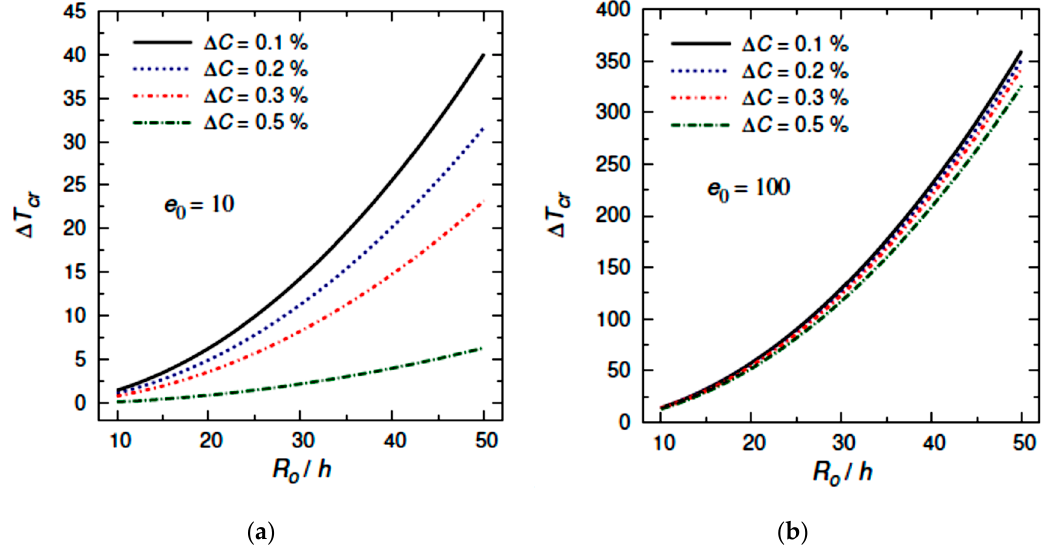
Figure 5. Effects of the outer radius to thickness ratio R o / h and moisture concentration ∆ C on the critical buckling temperature ∆ T cr of simply supported SGP annular plates for ( a ) e 0 = 10 and ( b ) e 0 = 100 ( R i / R o = 0.3, κ = 1, E ζ = 10 3 V/m, w g = 0.1%, µ = γ = 2 nm, J 1 = 100, J 2 = 10).